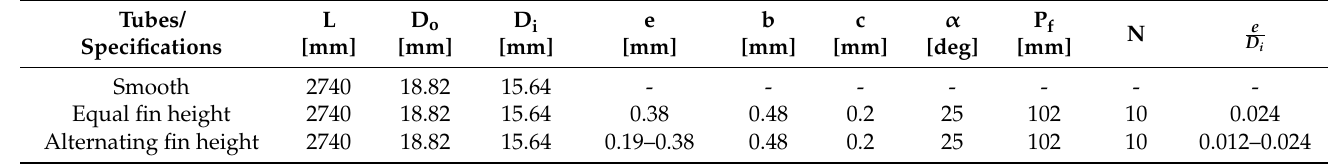
Table 2. Geometric parameters of studied